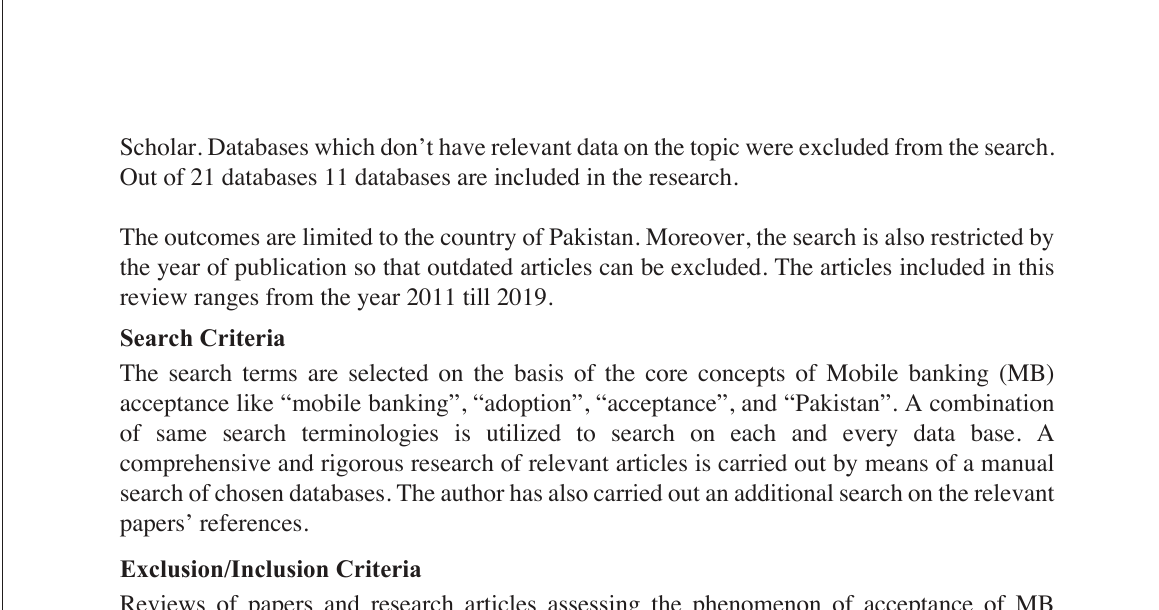
Table 2: Exclusion/Inclusion Criteria Data base